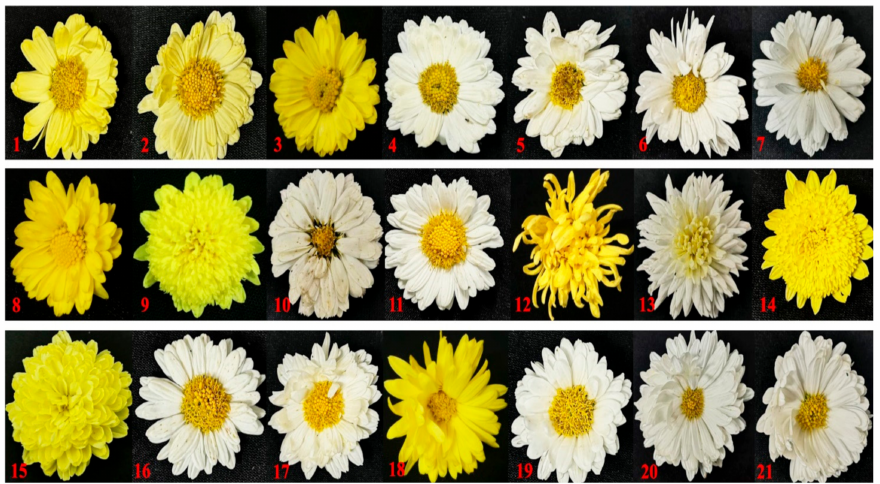
Figure 8. The flower morphology of 21 C. morifolium cultivars (1–21). Details of 21 C. morifolium cultivars are provided in Table